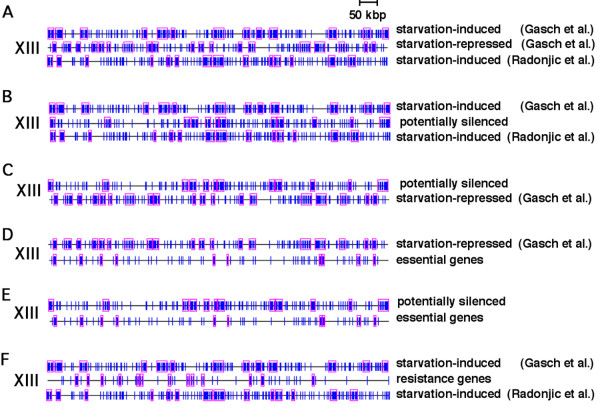
Gene maps of chromosome XIII are representative of the relationship between clusters of genes in the various datasets indicated in each panel. Vertical blue lines indicate the position of genes in the indicated datasets. Pink rectangles indicate clusters of genes detected by Pyxis that are unlikely to have formed by chance (p ≤ 0.05). Roman numerals indicate chromosome number. Additional Pyxis maps for all chromosomes are available in additional files 3, 4, 7.